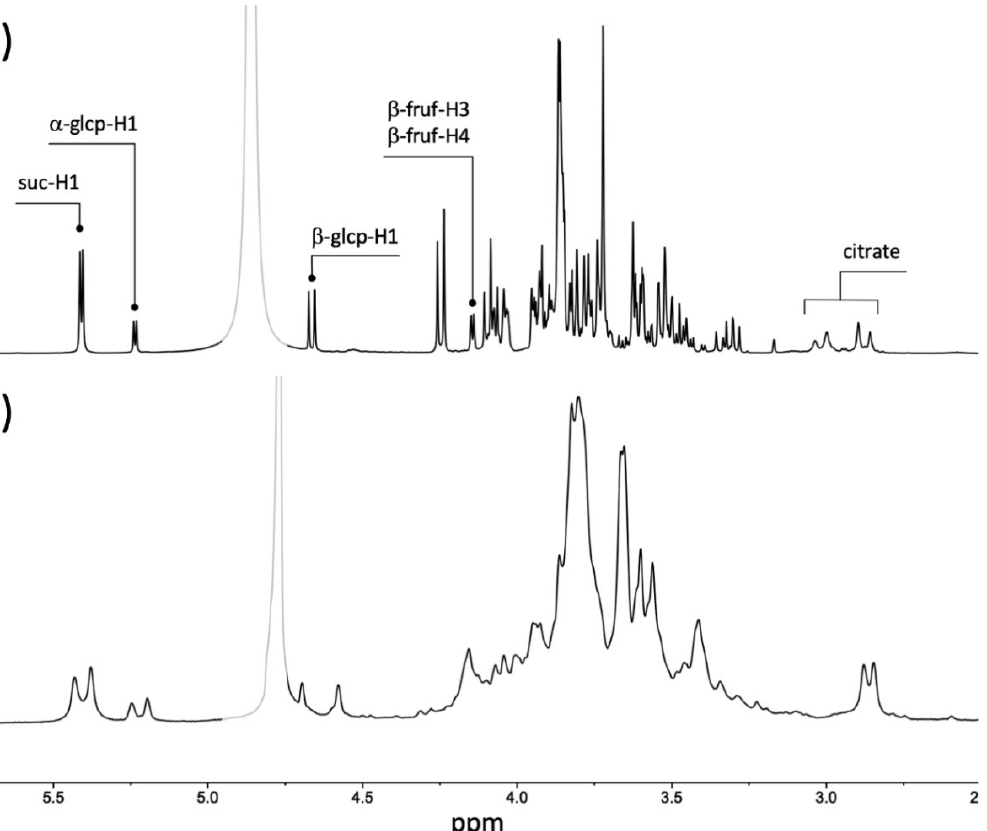
Figure 1. Comparison of 1 H spectra of the aqueous extract of mandarin variety B475B obtained with 400 and 60 MHz spectrometers ( a and b , respectively). Resonances employed in the estimations are annotated in the 400 MHz spectrum. The grayed-out region in both spectra corresponds to the residual HDO peak.